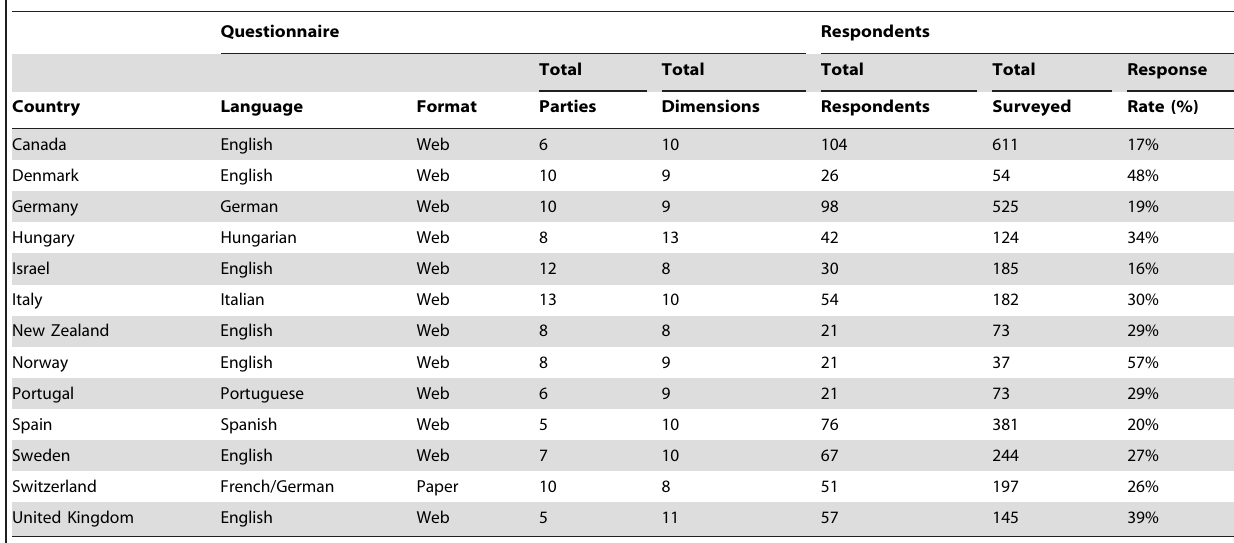
Table 1. Survey design for the 13 countries used in our